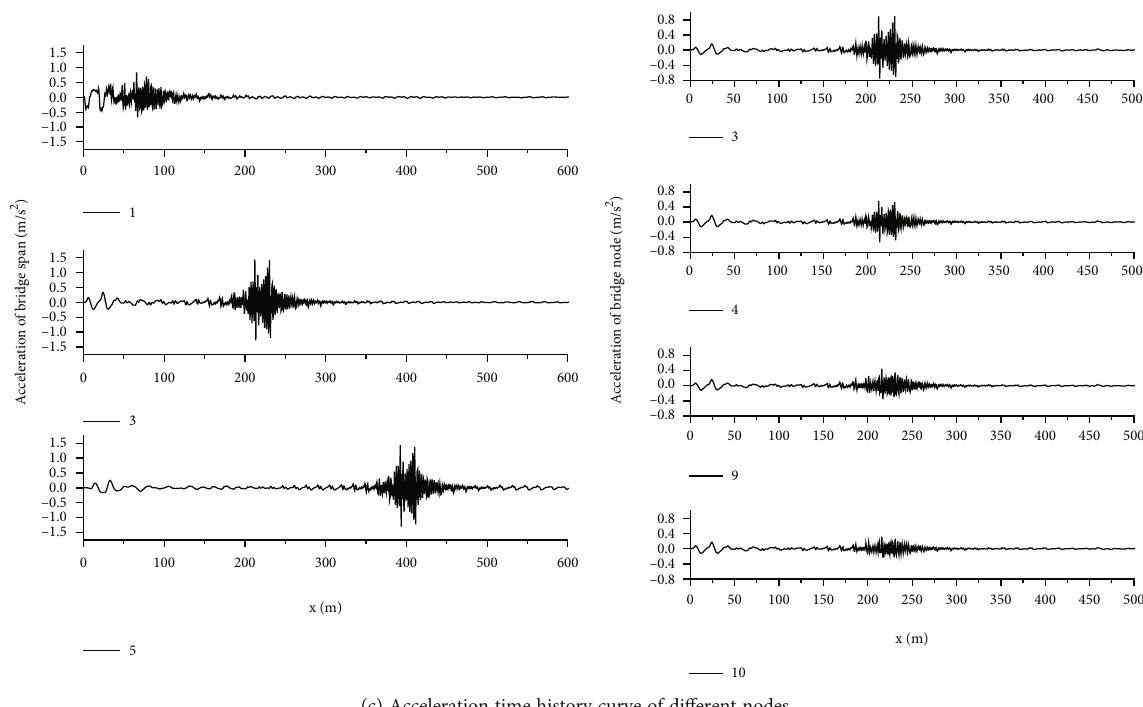
(c) Acceleration time history curve of di ff erent nodes Figure 5: The displacement time history curve of di ff erent nodes and conditions.